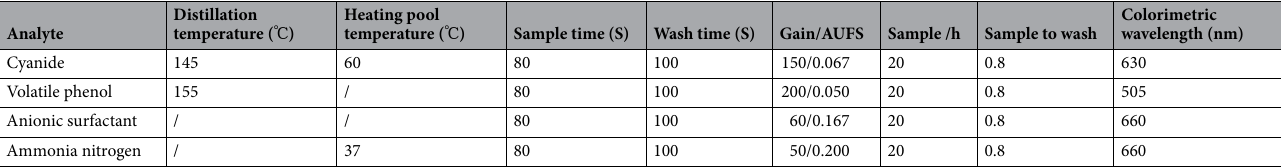
Table 1. Instrument conditions. "/" means room temperature, and there is no temperature requirement.